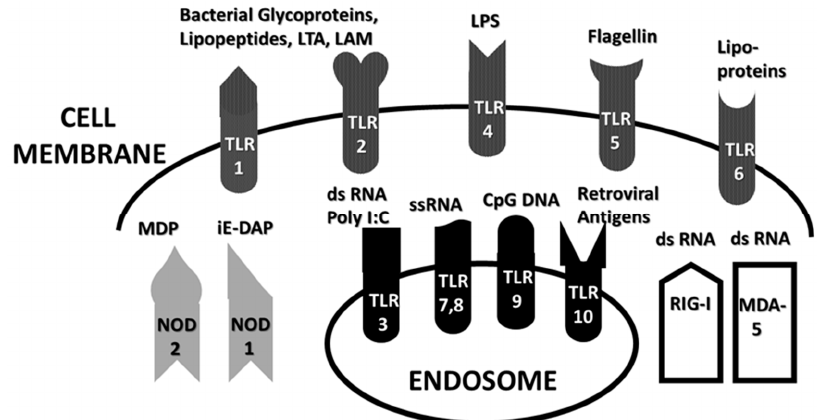
Figure 1. Schematic diagram summarizing locations (cell membrane, cytoplasm or endosome) on human innate immune system cells of the Toll-like receptors (TLR), nucleotide-binding oligomerization domain-containing proteins (NOD), retinoic acid-inducible gene I (RIG-1)-like receptors (RLR), RIG-I and the anti-melanoma differentiation-associated gene 5 (MDA-5). The main activating ligands are also shown: MDP-N-acetyl-muramyl-D-alanyl-isoglutamine-containing peptides; iE-DAP- γ -D-glu- meso-diaminopimelic acid (iE-DAP) dipeptide-containing antigens; LPS—lipopolysaccharides; poly I:C—a polymer of inosine and cytosine that mimics double-stranded RNA (dsRNA); ssRNA—single- stranded polyribonucleic acids; CpG DNA—cytosyl-p-guanosyl oligodeoxynucleotide deoxyribonu- cleic acid; dsDNA—double-stranded DNA; LTA—Lipoteichoic Acid; LAM—Lipoarabinomannan. LTA and LAM are found only in certain classes of